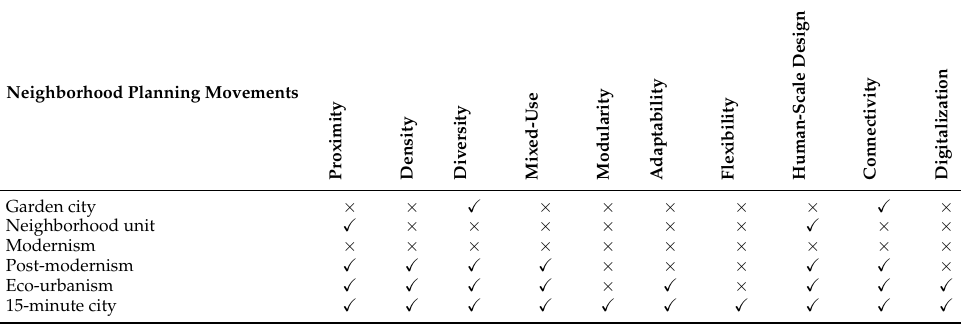
Table 1. Comparing neighborhood planning movements. Absence of the principles is indicated by × and presence is shown by (cid:88)